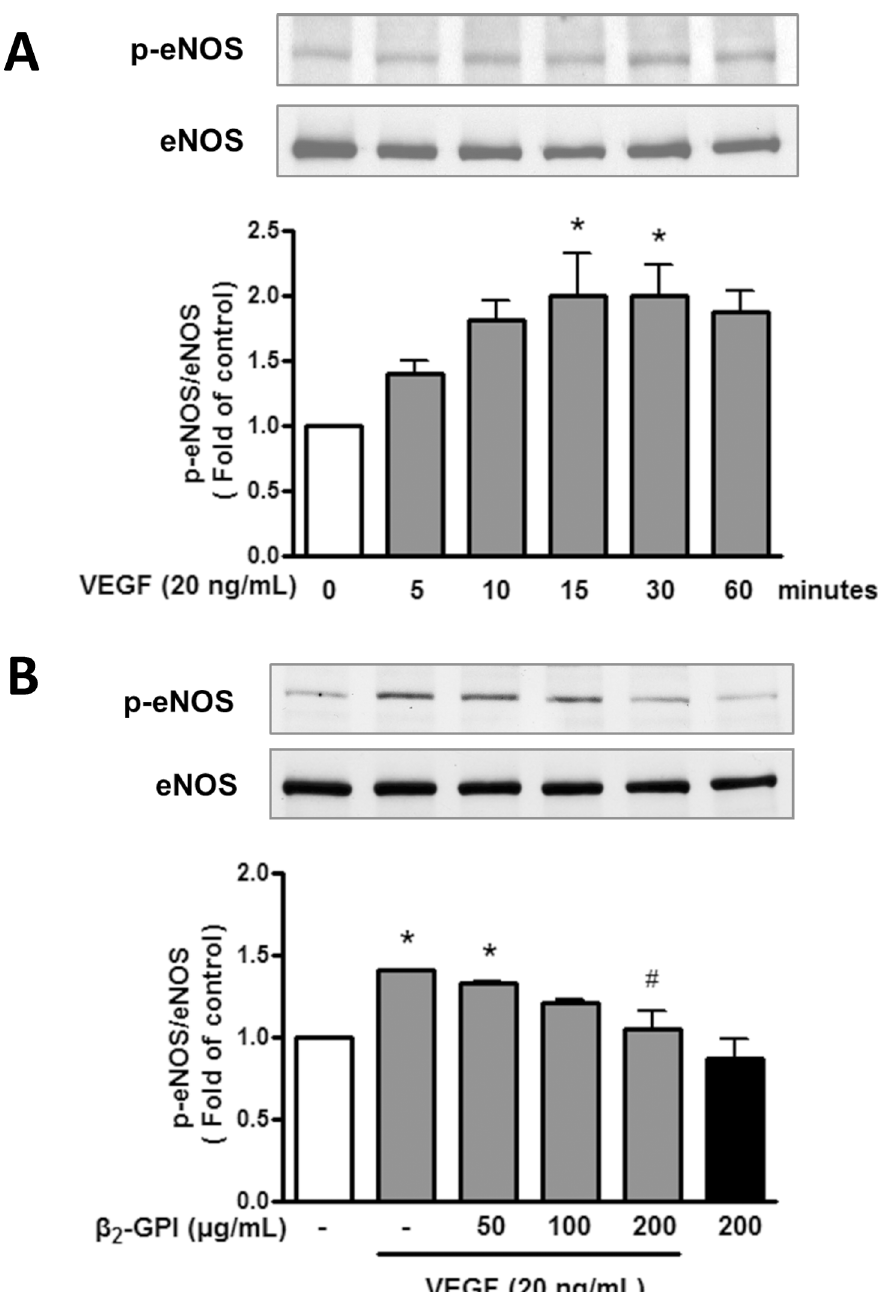
Fig 6. β 2 -GPI inhibits the VEGF-induced eNOS phosphorylation in HAECs. (A) A time course of eNOS phosphorylation in HAECs treated with VEGF was determined by Western blot analysis. The intensity of the eNOS phosphorylation band was normalized against total eNOS expression and was calculated as the fold of control (set as 1). (B) The effect of β 2 -GPI on VEGF-induced eNOS phosphorylation was determined in HAECs treated with or without VEGF in combination with β 2 -GPI at indicated concentrations. Results are expressed as mean ± SEM and representative of more than three independent experiments. * p < 0.05 versus control; # p < 0.05 versus VEGF treatment